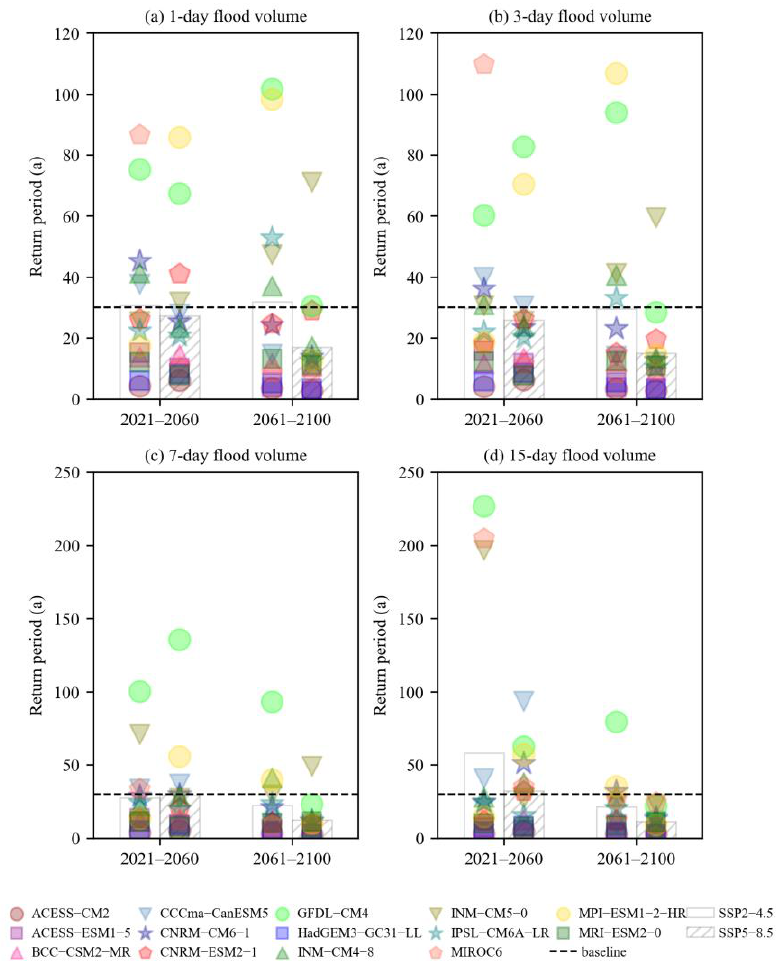
Figure 8. Projected flood frequency of current 30-year value (1971–2010) of 1-, 3-, 7-, and 15-day floods ( a – d ) in the Fujiang River basin for 2021–2060 and 2061–2100 under 14 GCMs and 2 SSP-RCPs.